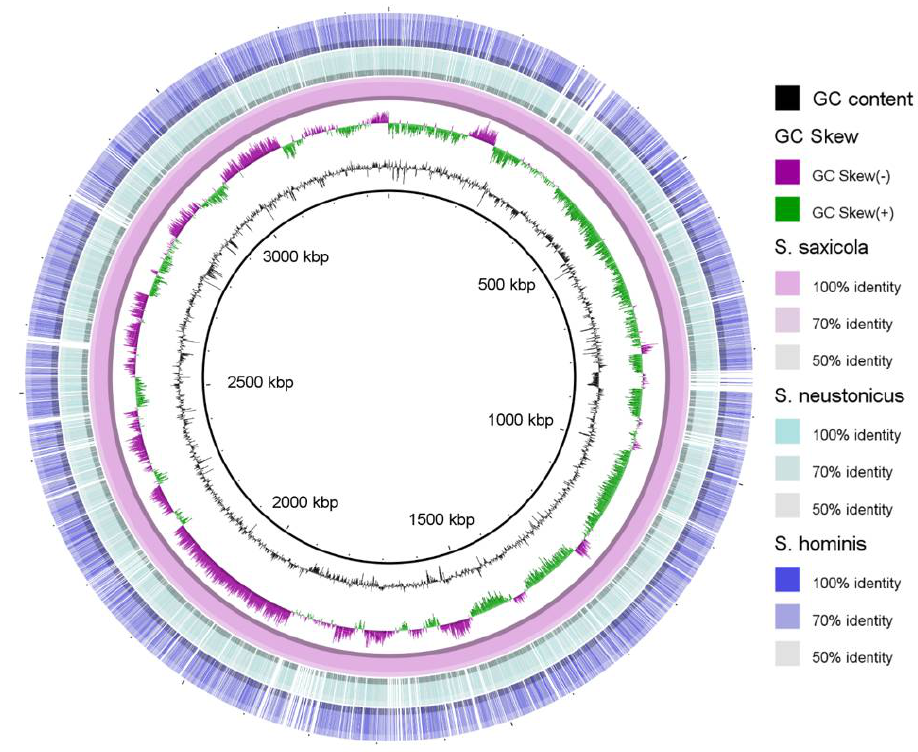
Figure 4. Overall genome sequence identity distribution between S. saxicola M6 T , S. hominis SZY PN-1 T , and S. neustonicus PAMC 28131 T . Location in the reference genome is indicated by numeration on the inside of the ring. GC content in the reference genome is indicated by the black bar graphs between the genomic coordinates and the colored ring. The graphical view of the alignments was rendered using the BLAST Ring Image Generator (BRIG) [34].